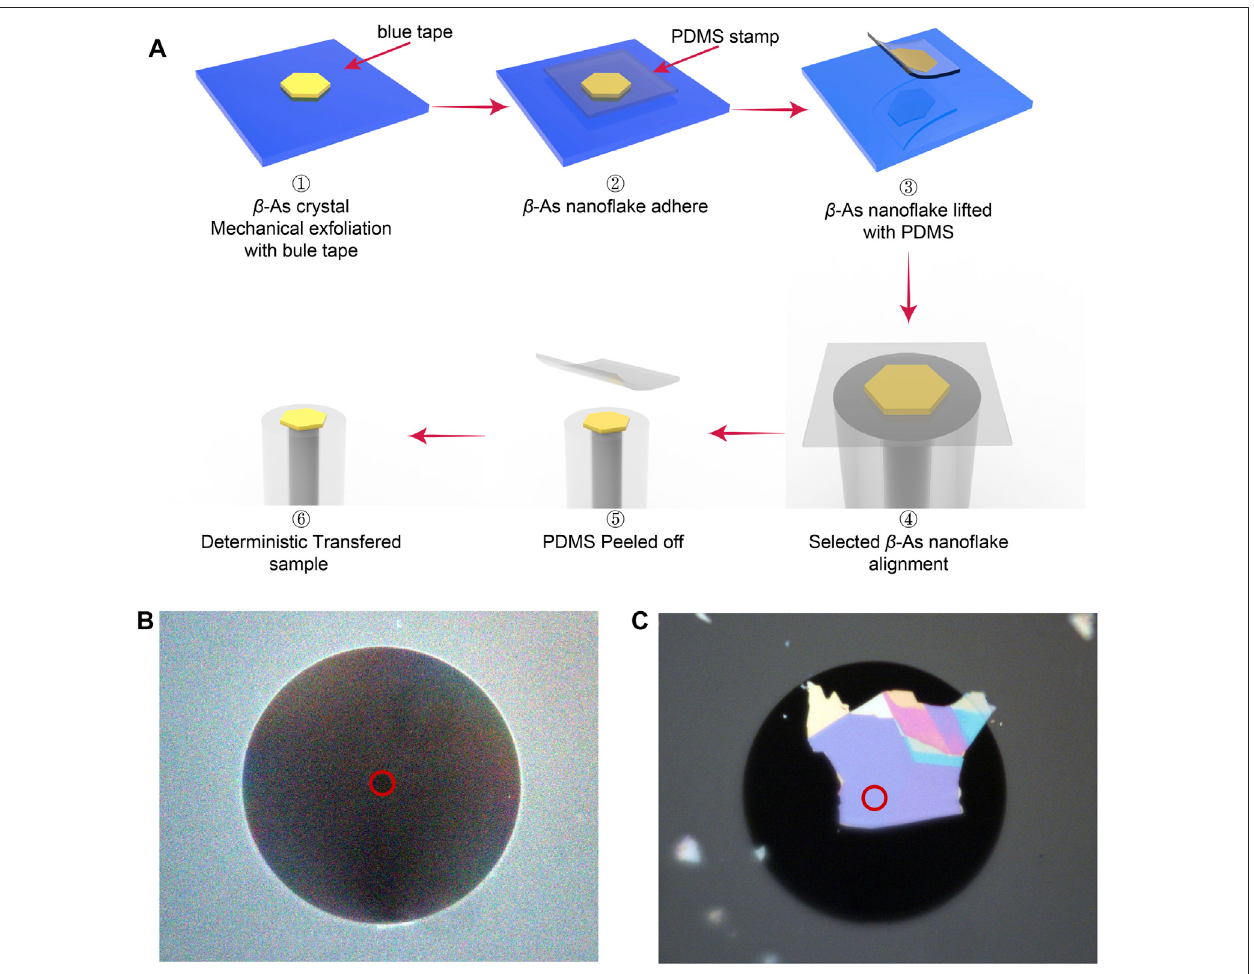
FIGURE3| Deterministictransferof β -Asnano fl akeon fi berendcap. (A) Theprotocolofdeterministictransfer:step1, β -Asbulkcrystalmechanicalexfoliationwith blue tape; step 2, β -As nano fl ake adhere; step 3, β -As nano fl ake lifted with PDMS; step 4, the selected β -As nano fl ake alignment; step 5, PDMS peeled off; step 6, deterministictransferredsampleof β -Asnano fl ake. (B) Microscopedigitalimageofthe fi berendcap(diameterofredcircleis9 μ m)beforetransfer. (C) Microscopedigital image of fi ber end cap after deterministic transfer of β -As nano fl ake.